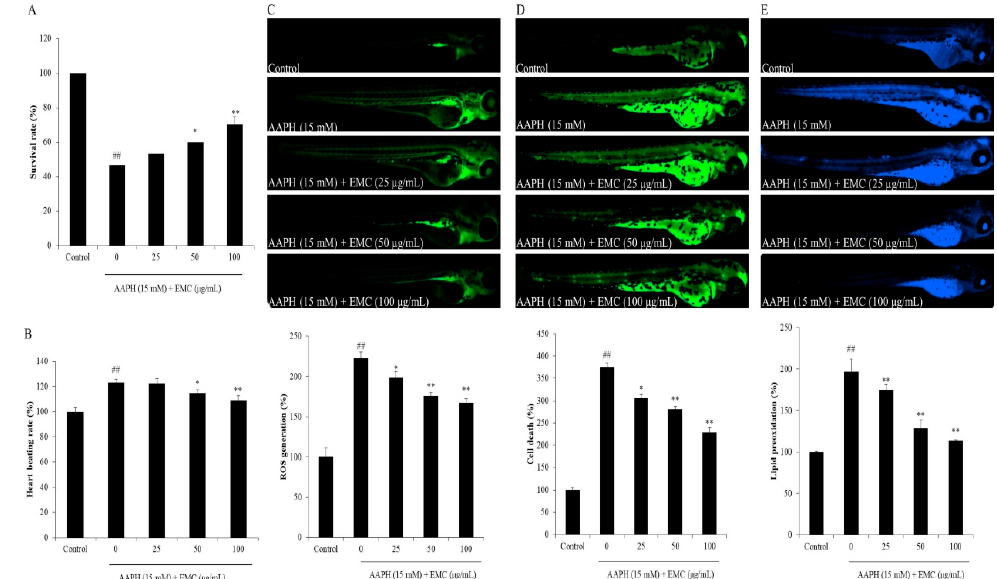
Figure 3. EMC attenuates AAPH-induced oxidative damage in vivo in zebrafish. ( A ) Survival rate of zebrafish; ( B ) heart beating rate of zebrafish; ( C ) intracellular ROS generation of AAPH-stimulated zebrafish; ( D ) cell death of AAPH-stimulated zebrafish; ( E ) lipid peroxidation of AAPH-stimulated zebrafish. The relative fluorescence intensities of whole zebrafish body were determined using Image J software. The experiments were conducted in triplicates, and data are expressed as the mean ± SE. * p < 0.05, ** p < 0.01 as compared to the AAPH-treated group and ## p < 0.01 as compared to the control